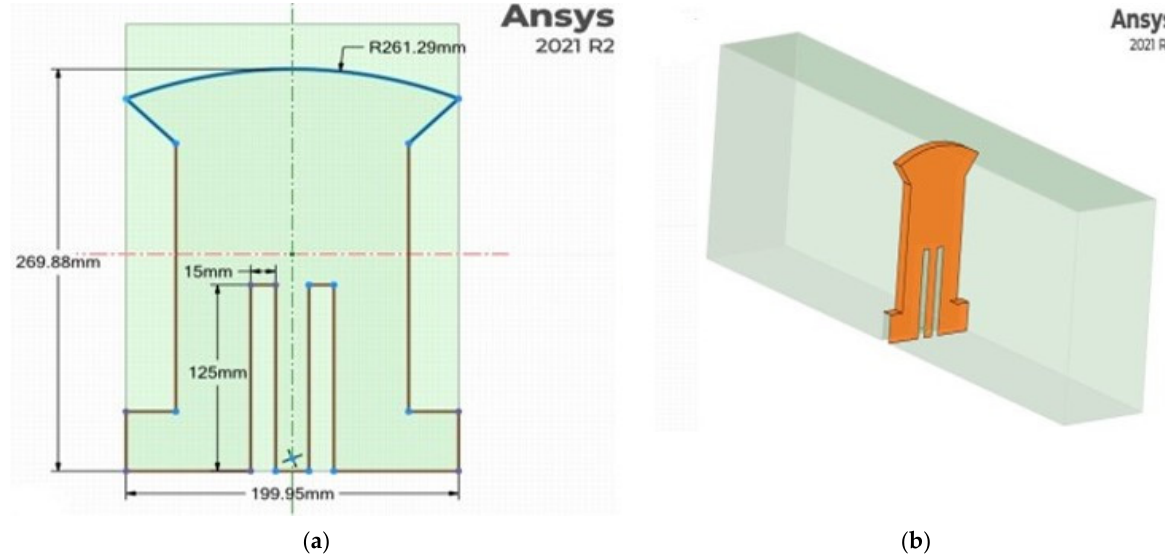
Figure 2. Schematic diagram showing: ( a ) Dimensions of rectangular tank with imperforate baffle; ( b ) Generated mesh of rectangular tank.